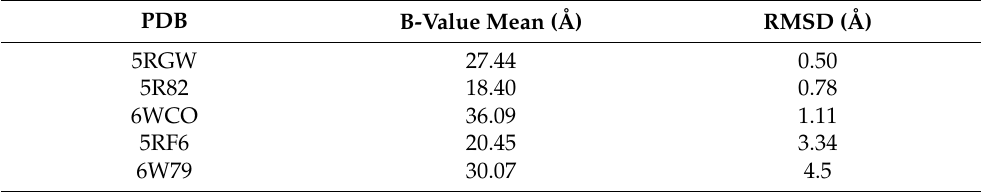
Table 5. List of the best 5 PDBs with B-value and cognate docking results RMSD, expressed in (Å).